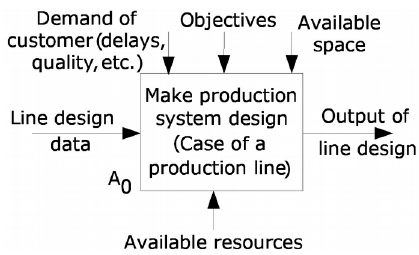
Figure 4. Assembly line design (level A